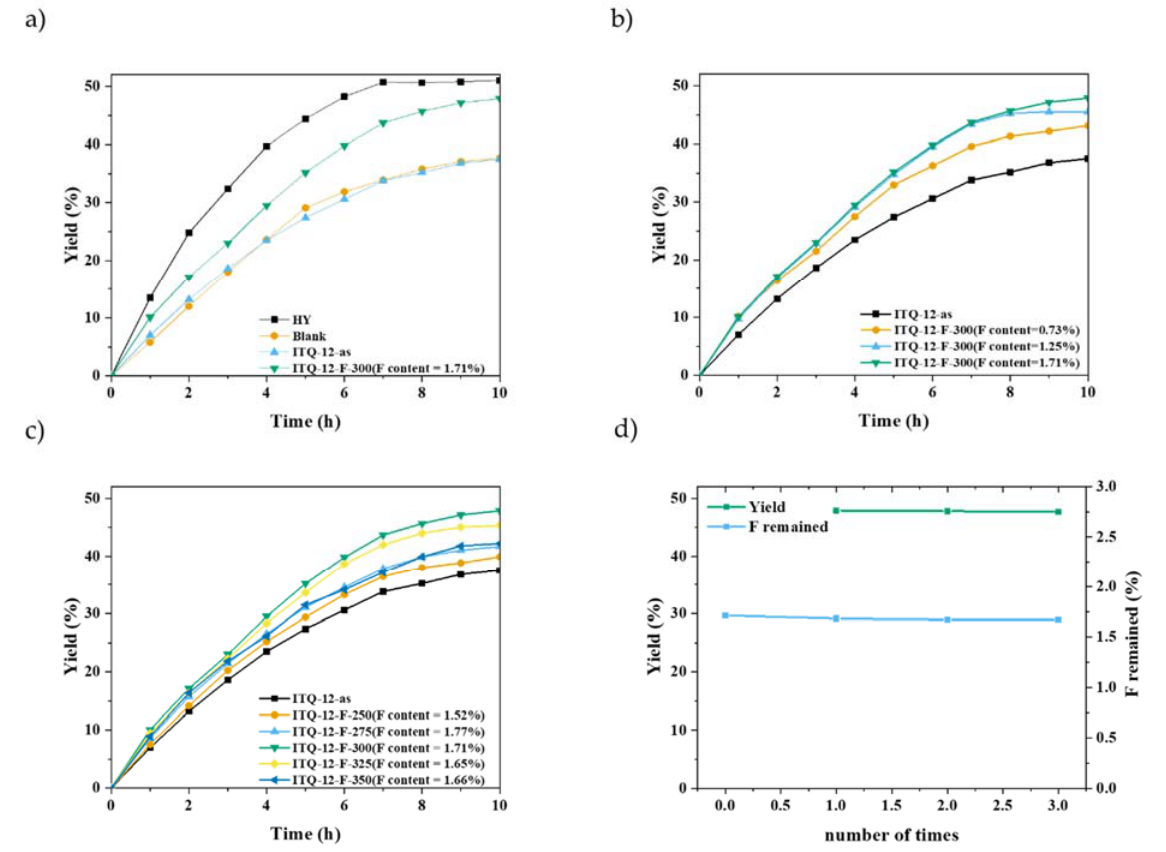
Figure 3. Biginelli reaction yield of ( a ) various zeoilte catalysts and blank; ( b ) ITQ-12-F-300 with various F − contents; ( c ) ITQ-12 treated in various temperature; ( d ) reusing ITQ-12-F (The reaction conditions are 80 °C for 10 h).